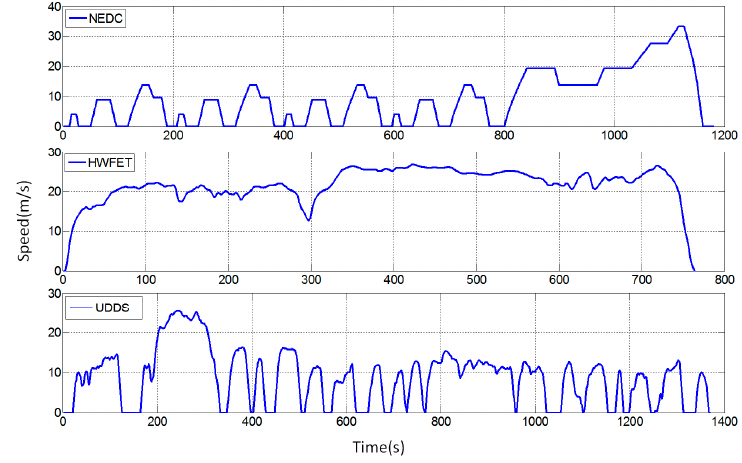
Figure 9. Profile of simulation driving cycles.